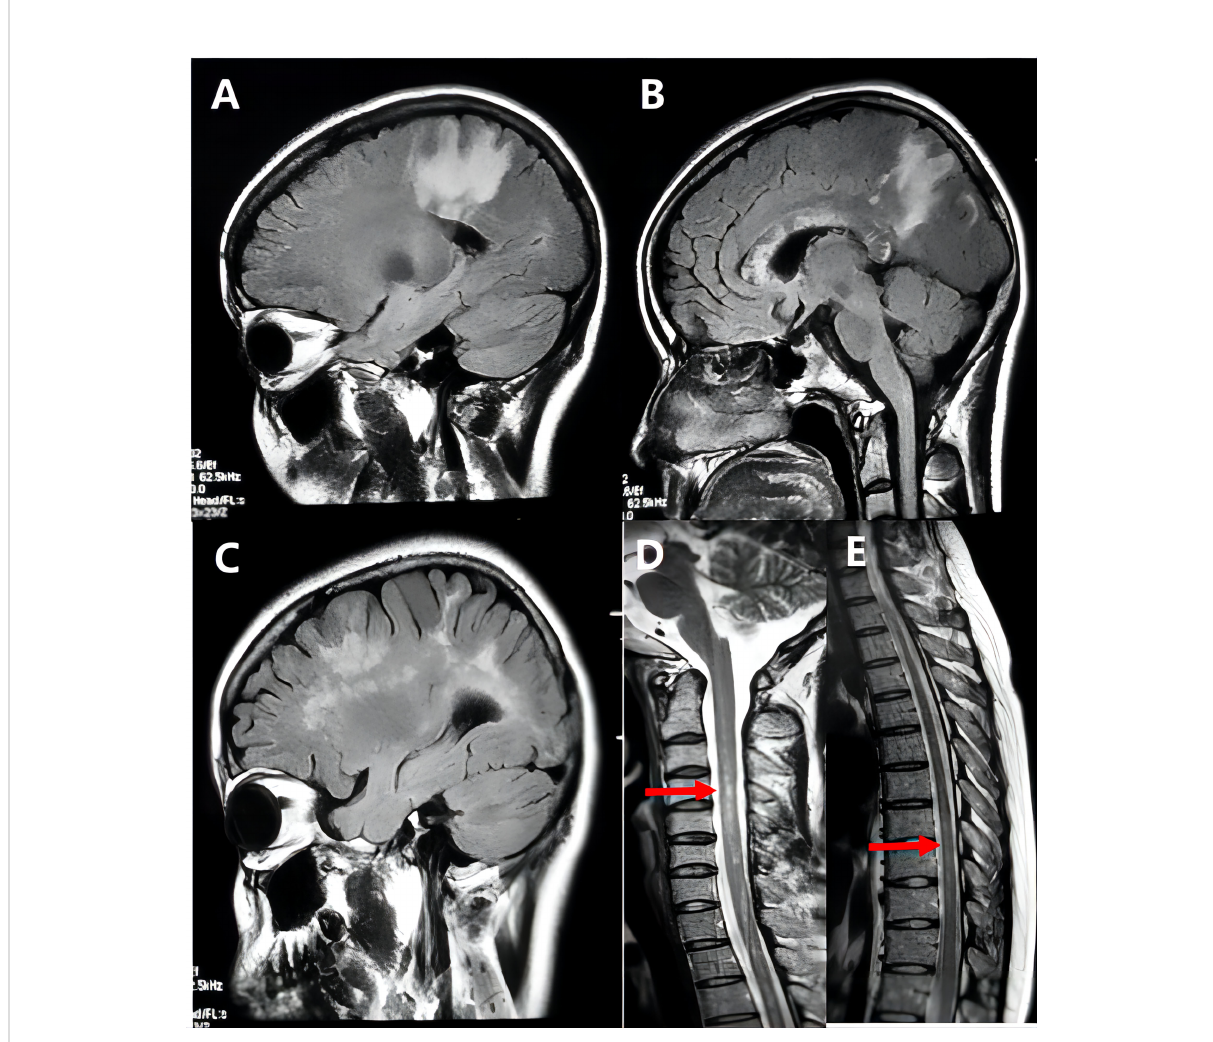
FIGURE 2 Representative example of tumefactive neuromyelitis optica spectrum disorders (NMOSD). A 26-year-old woman ’ s MRI scan at the disease onset showed extensive hyperintensity on T2 FLAIR images in the patient ’ s frontal lobe, parietal lobe, and corpus callosum (A, B) , and the lesions gradually decreased after treatment; after 4 months of the fi rst attack, the patient developed more brain lesions than before (C) , and spinal MRI revealed long-phase abnormal signal at C3-T7 (D, E) . And the patient ’ s serum anti-AQP4 antibody was strongly